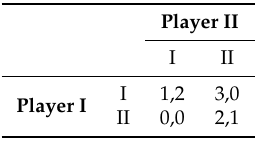
Table 2. A bi-matrix game where Nash and leader equilibrium are not